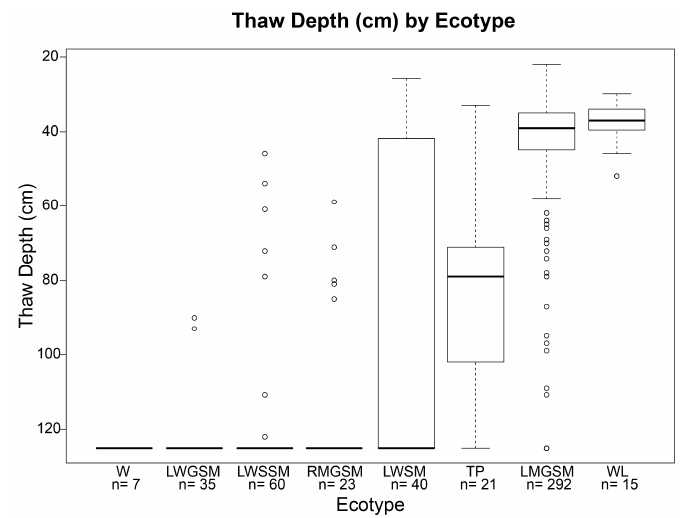
Figure 5. Thaw depth by ecotype. Bold horizontal lines show the median thaw depth for each transect, the boxes show the Inter-Quartile Range (IQR), and the whiskers show 1.5 × IQR ± 1st and 3rd quartiles, respectively. Circles beyond the whiskers indicate outliers. Note that the maximum thaw depth was the length of the thaw probe and depths of 125 cm indicates a lack of permafrost in most cases.